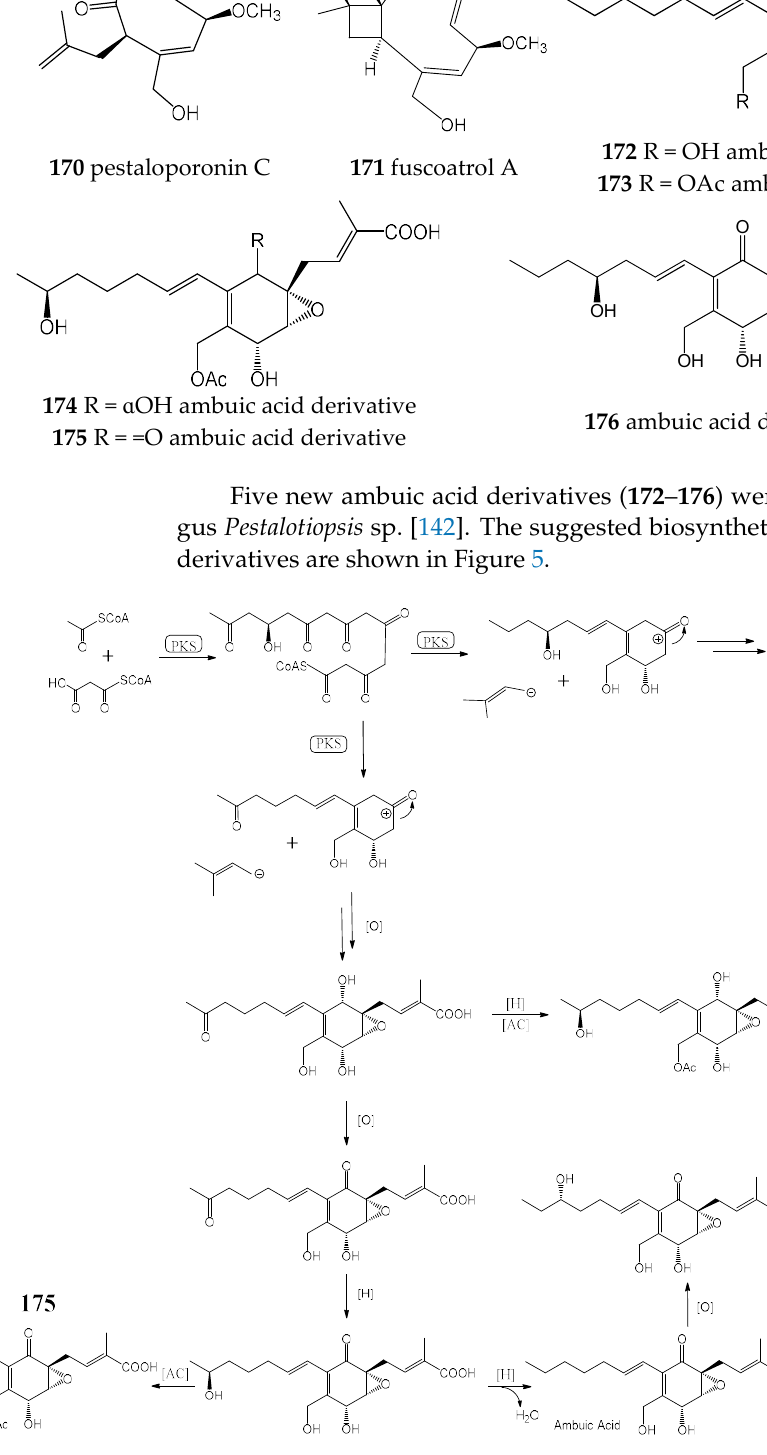
Figure 5. The suggested biosynthetic pathways of ambuic acid and its derivatives [142].